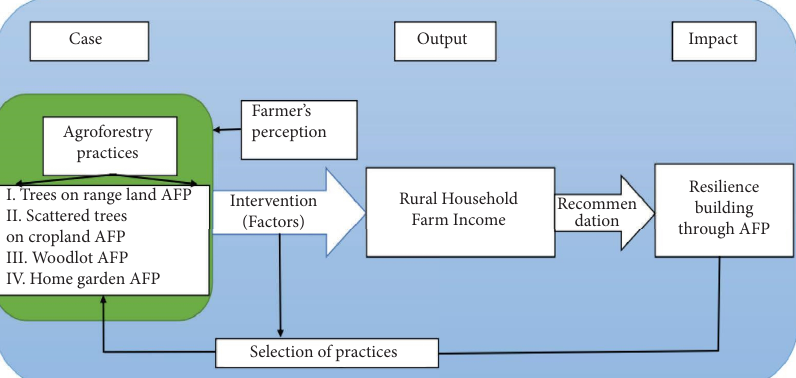
Figure 1: Conceptual